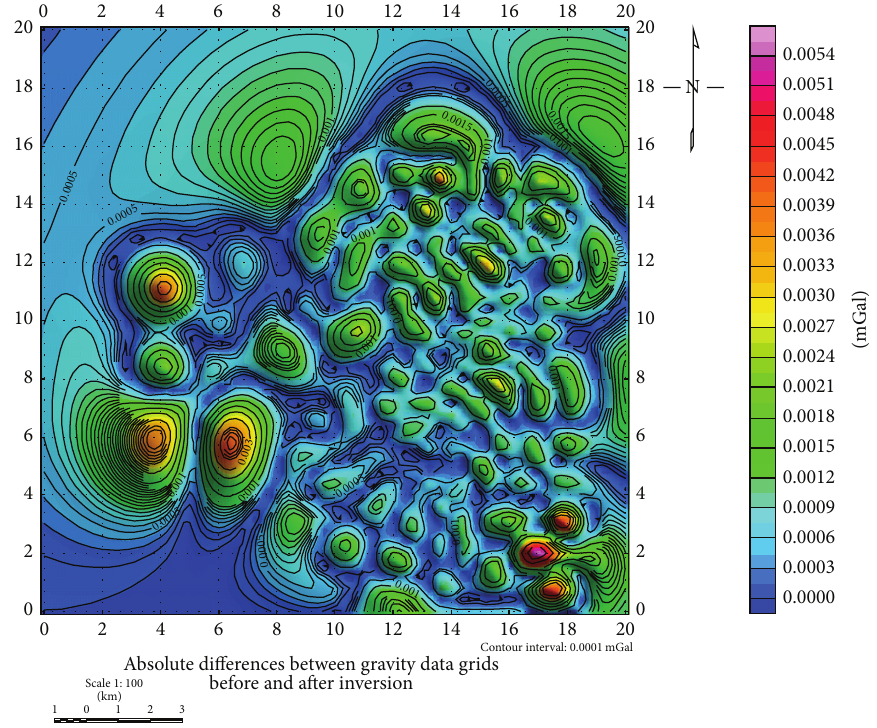
Absolute differences between gravity data grids before and after inversion Figure 13: Spatial distribution of residuals along the grid and their amplitudes, computed as the absolute differences between gravity data before and after